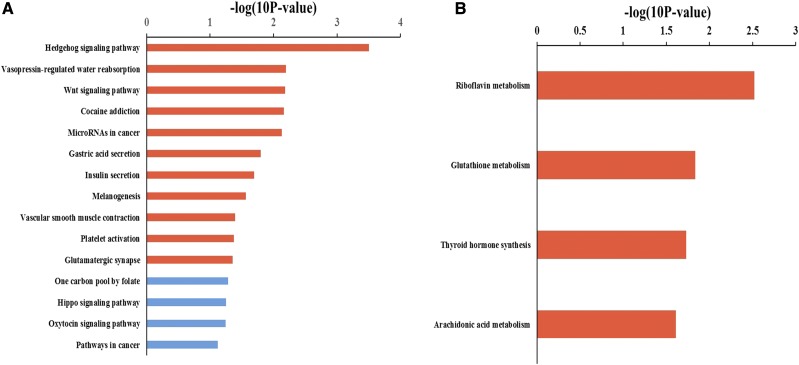
Top 15 pathways of candidate target mRNAs. a. Two- vs. 6-month-old testes; b. 2- vs. 12-month-old testes; red terms represent P < 0.05.